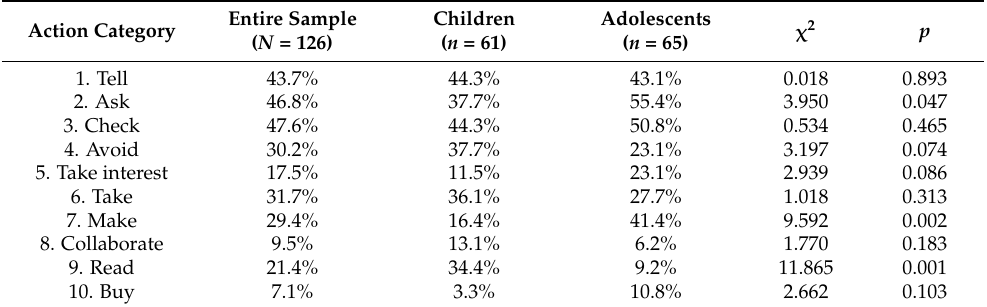
Table 2. Comparison of action category use between children (8–11 yr) and adolescents (12–18 yr). Action Category